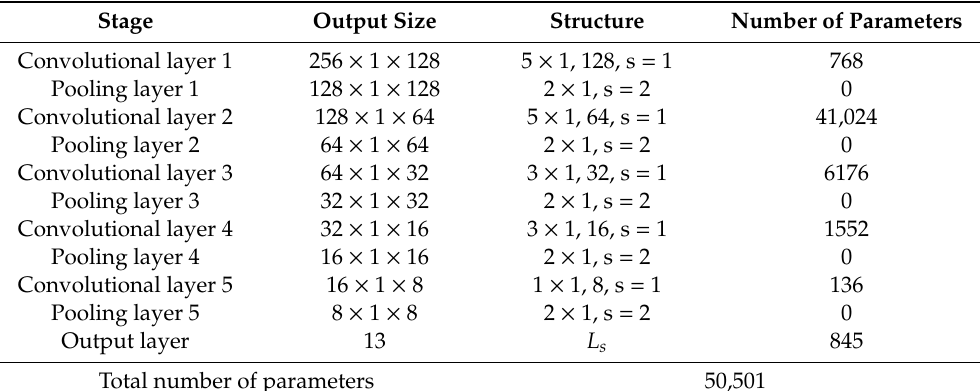
Table 6. Details of structure and parameters of